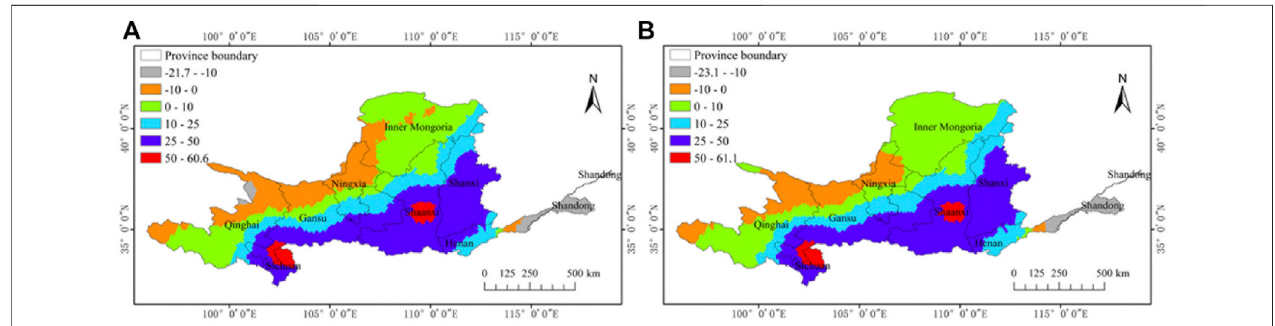
FIGURE 9 | Annual total precipitation deviations of grid-based BMA (A) and BMA (B) ensembles with observation in 1986 – 2005 (mm, positive deviation means overestimation; minus means underestimation).